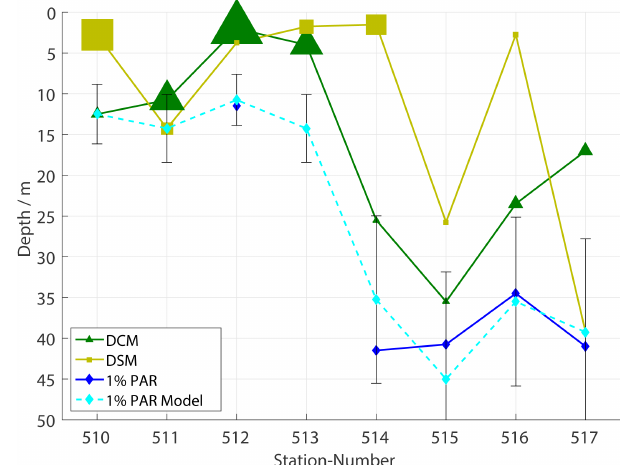
Figure 8. DCM (green, deep chlorophyll max.) and DSM (ocher, deep SPMi max.) at all stations in Uummannaq Fjord from west to east. The size of the markers represents the integrated Chl a and SPMi concentrations from the top of the water column to the mod- eled 1% depth. Measured 1% PAR (blue) where available and mod- eled 1% PAR as a dashed line (cyan).